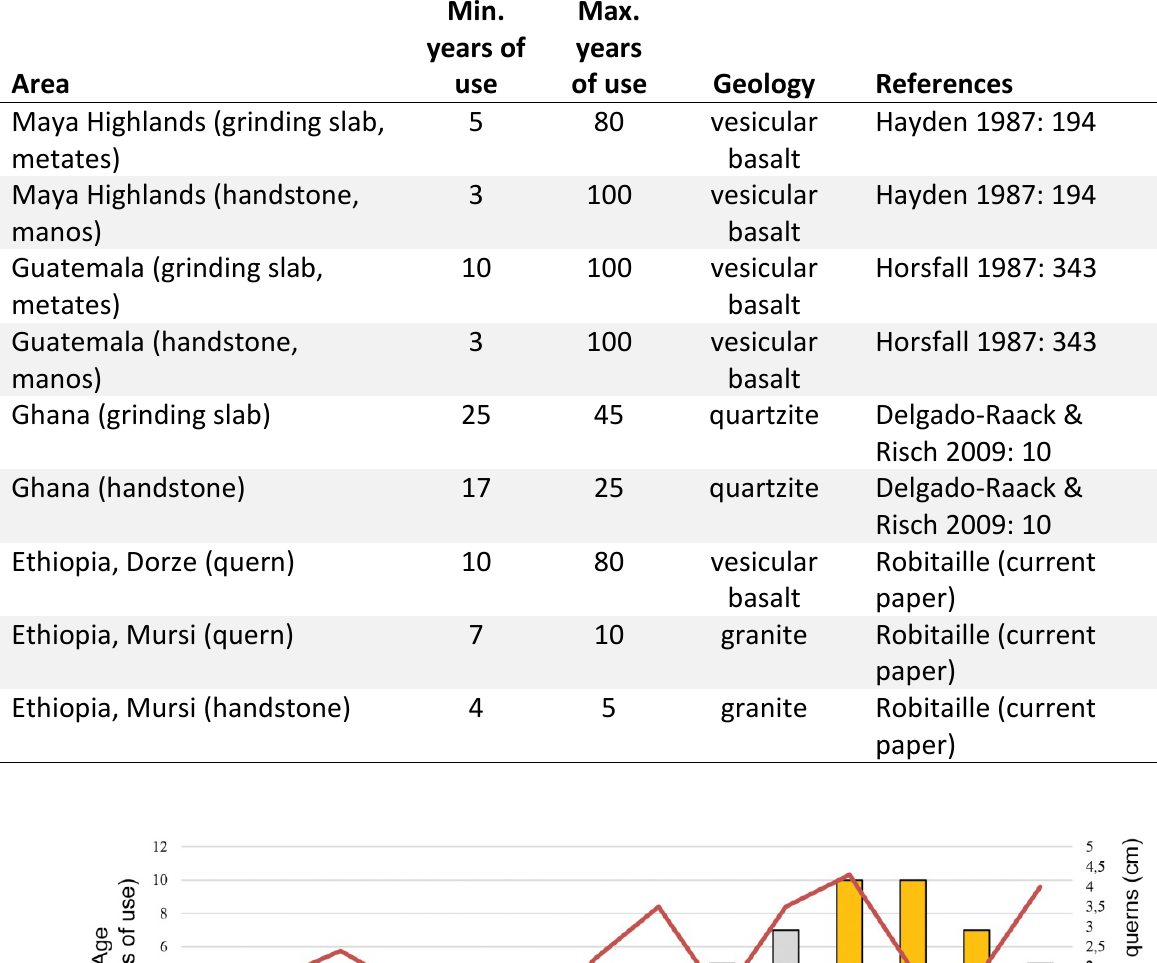
Table 1. Comparative table showing the average minimum and maximum ages of stone tools that are used in Central America and Africa.